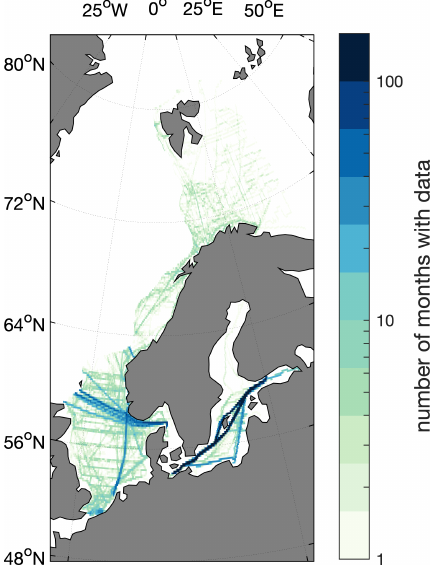
Figure 2. The number of months with f CO 2 data from SOCAT v5 in each grid box. The data cover a range of 20 years (240